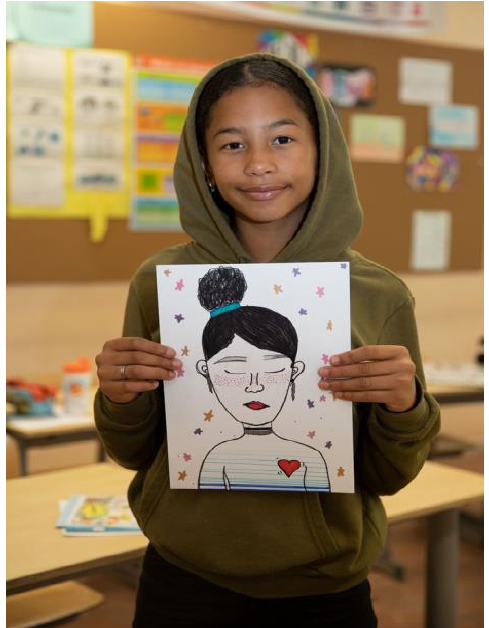
Figure 7. Mindfulness was favorite lesson.